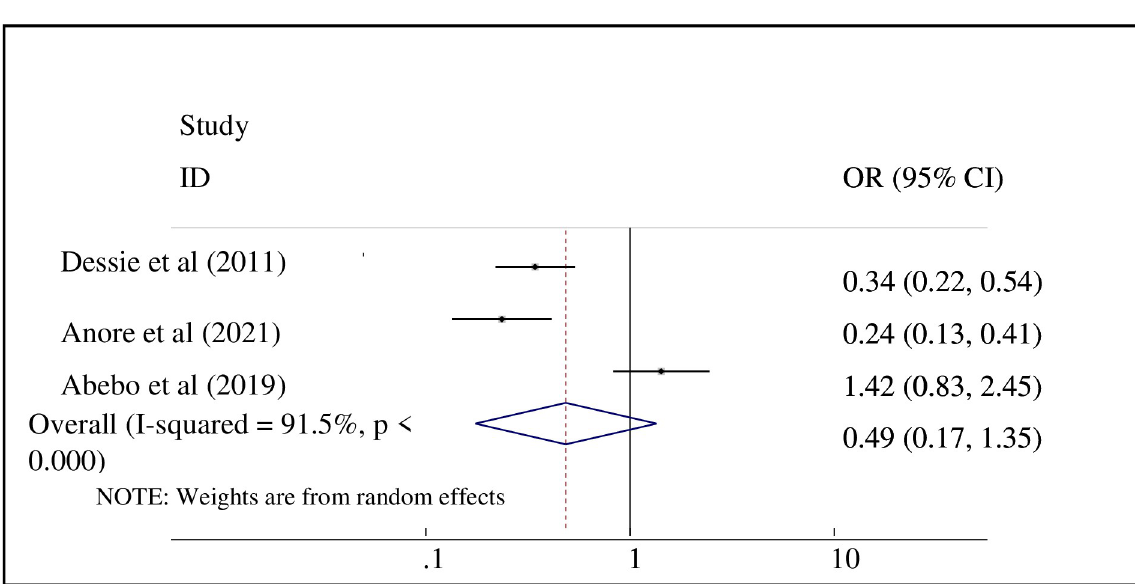
PLOS ONE | https://doi.org/10.1371/journal.pone.0266884 April 14,